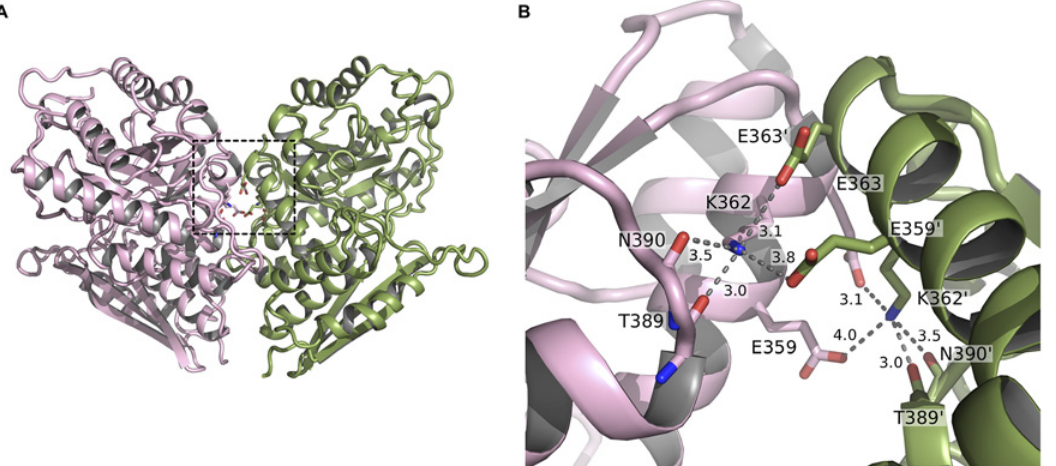
Fig 8. K362 interactions in wild-type SEN. ( A ) SEN minor interface with residues interacting with K362 shown as stick representations. ( B ) Close-up view of the area bounded by a dashed line in (A) showing the potential hydrogen bond network involving K362, T389 and N390 of the same monomer, and E359 ’ and E363 ’ of the opposing monomer.